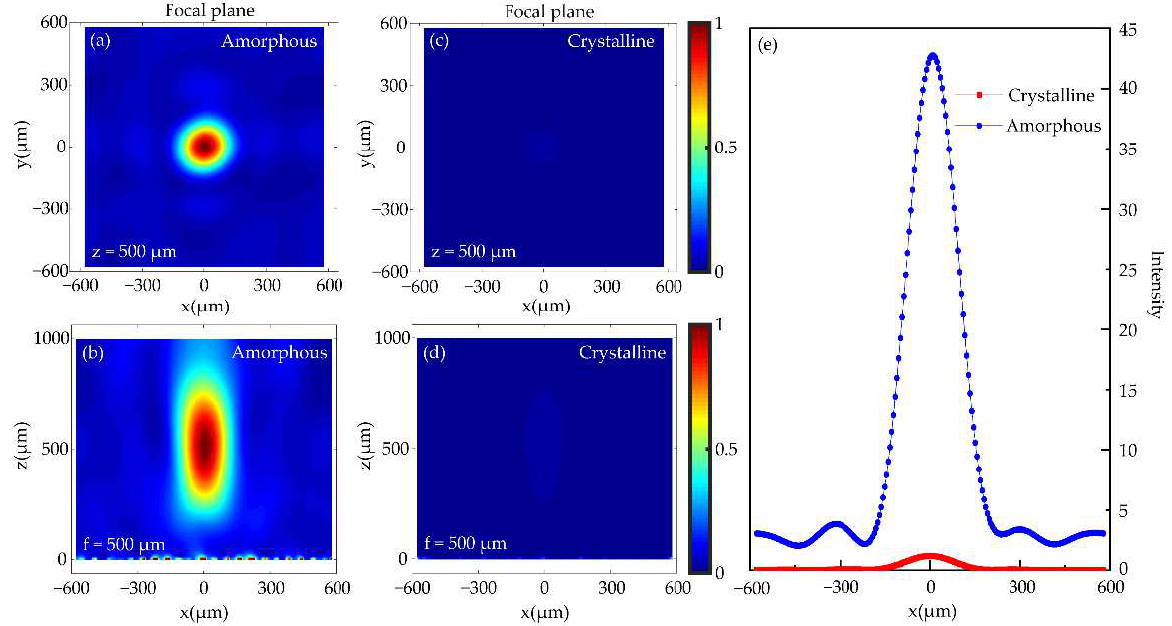
Figure 8. Under illumination of 1.05 THz LCP light, the sectional views of GST in amorphous ( a , b ) and crystalline ( c , d ) on focal plane z = 500 μm and plane y = 0 μm of the focusing metalens. ( e ) Electric field intensity distribution of z = 500 μm sectional view along x -axis in GST two states.